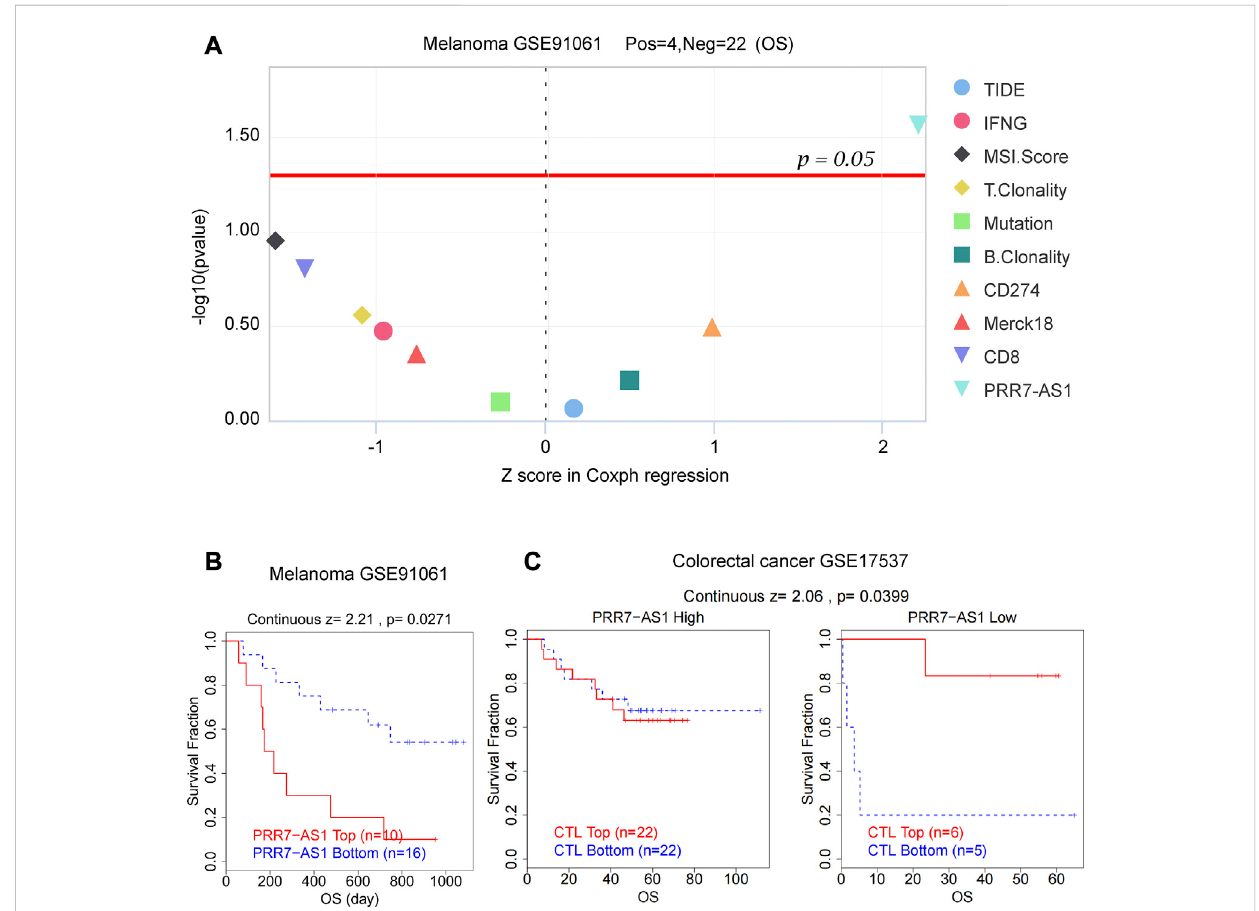
FIGURE 8 PRR7-AS1 predicted the ef fi cacy of immunotherapy. (A) Z score in Coxph regression analysis of different predictors for immunotherapy ef fi cacy in melanoma. (B) Kaplan-Meier curves of the OS in melanoma patients treated with PD1 inhibitors. (C) The overall survival analysis of patients in colorectal cancer with different PRR7-AS1 expression and CTL